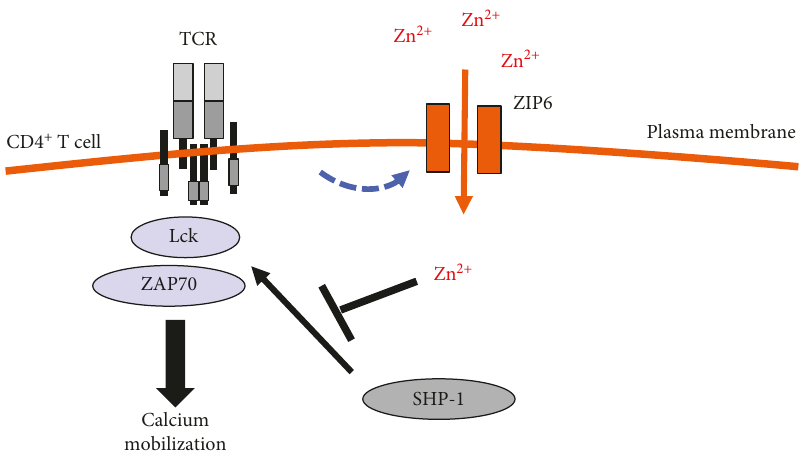
Figure 3: Zn functions as an ionic signaling molecule after T cell activation. Cytoplasmic zinc concentrations increased within 1min after TCR triggering as the result of an in fl ux via the zinc transporter Zip6 . The increase was most pronounced in the immediate subsynaptic area and enhanced TCR signaling, at least in part as a result of the inhibition of SHP-1 recruitment. TCR: T cell receptor; Zn: zinc; SHP-1: Src homology region 2 (SH2) domain-containing